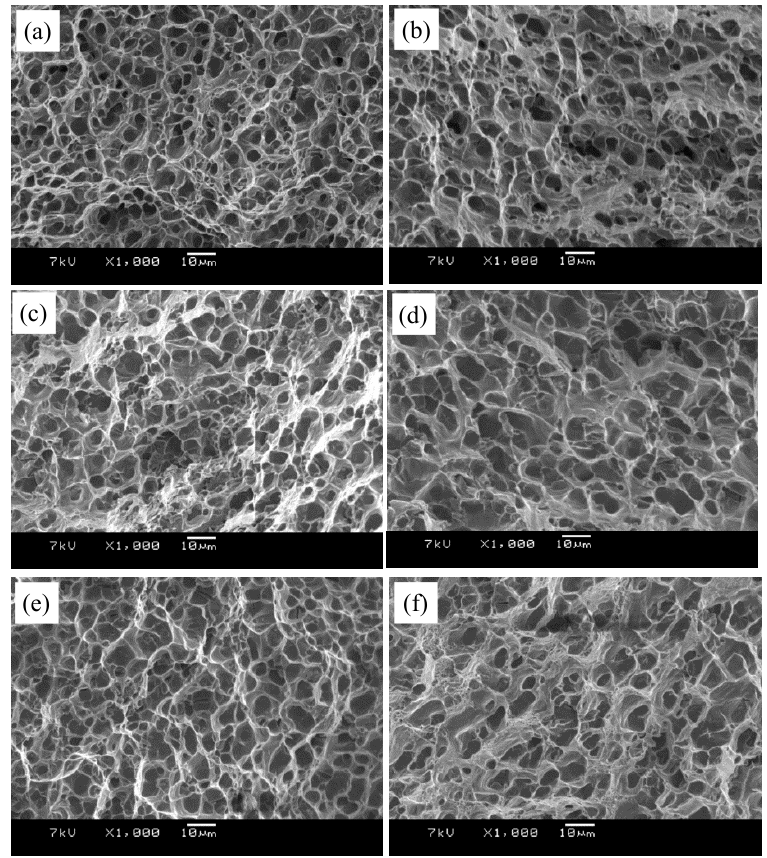
Figure 13. SEM images of the fractography for: ( a ) T1; ( b ) T1 ‐ FSW; ( c ) T4; ( d ) T4 ‐ FSW; ( e ) T6; ( f ) T6 ‐ FSW.